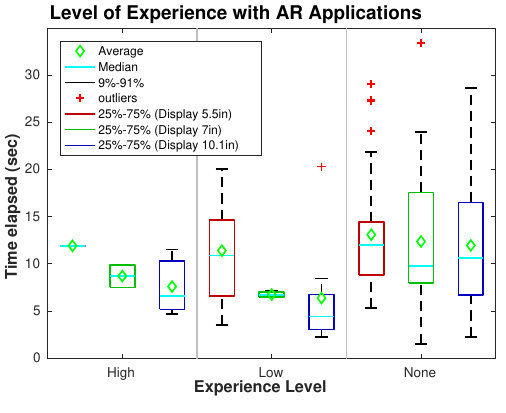
Figure 6. Results of the analysis considering groups of volunteers according to their experience with AR applications. The results obtained in this analysis are relatively similar